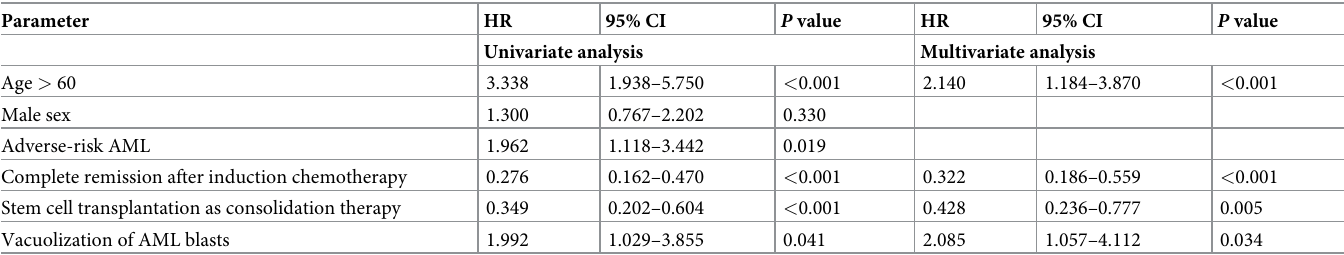
Table 7. Univariate and multivariate analysis associated with survival in AML patients.